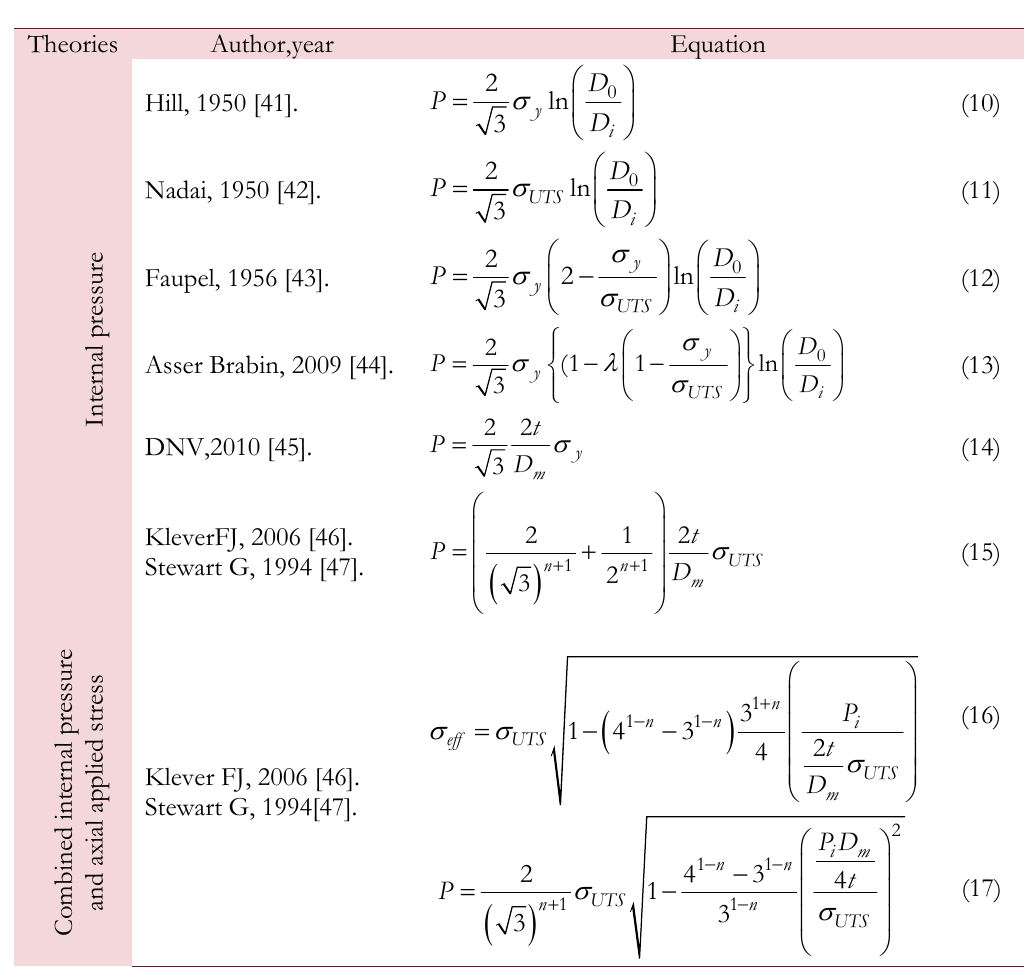
Table 2: Overview of multiaxial fracture in the limit